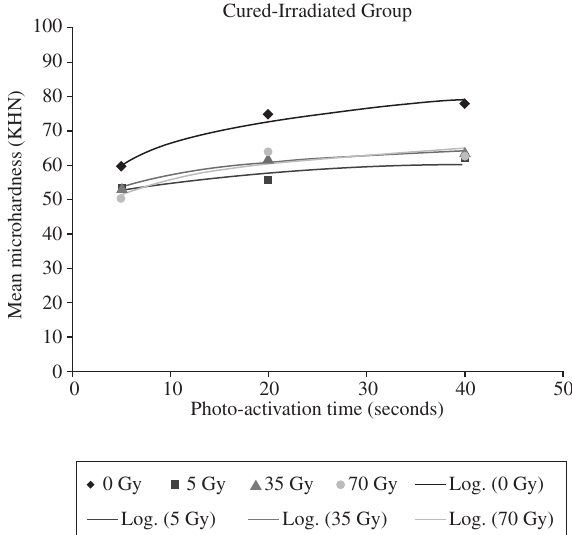
Figure 1. Regression analysis of microhardness averages of the Filtek Z250 TM material to cured-irradiated groups in accordance with radiation dose as a function of the photo-activation time.